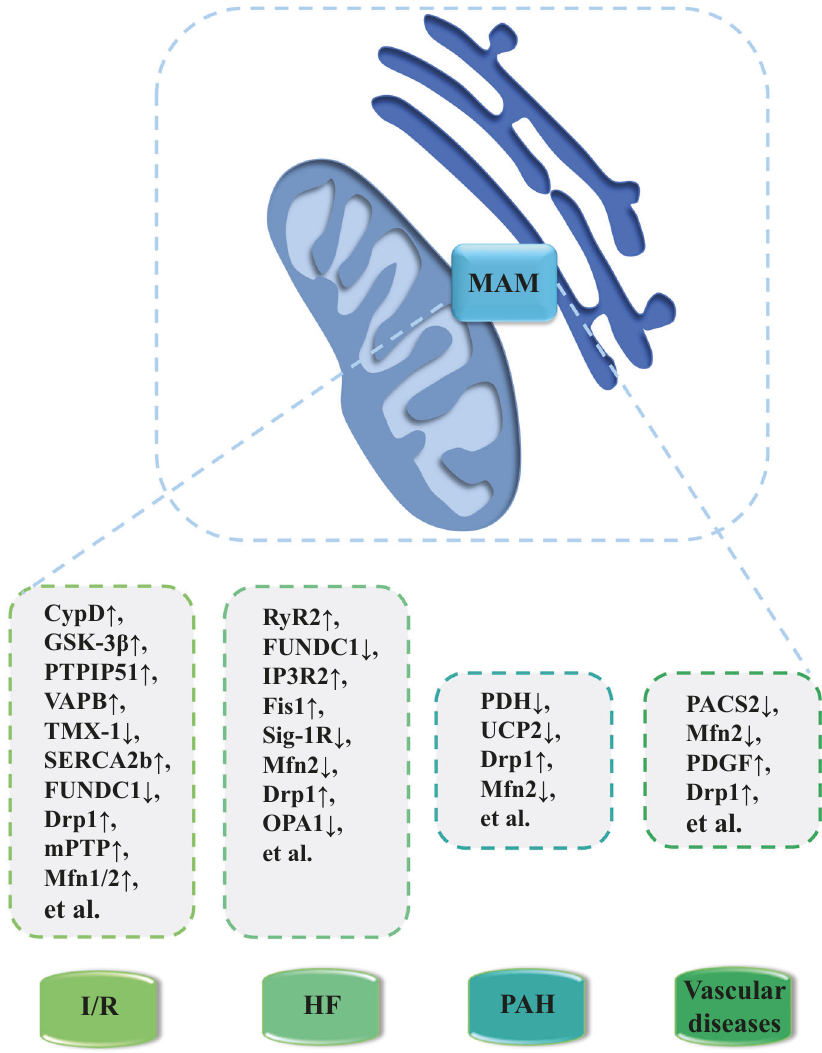
Fig. 3 MAM-enriched proteins as potential new therapeutic targets for the treatment of CVD pathologies. Disruption or de fi ciency in ER- mitochondria communication is crucial in the pathogenesis of various CVDs such as I/R, HF, PAH and vascular diseases. For example, expression level of CypD, PTPIP51 and mPTP is elevated in I/R, whereas downregulation of FUNDC1, Sig-1R and OPA1 is noted in HF. Drp1 level is increased while Mfn2 level is decreased in PAH and vascular diseases. Notably, the key regulatory proteins of these processes serve as promising therapeutic targets in the management of these pathological conditions. Abbreviations: CVD, cardiovascular diseases; CypD, Cyclophilin D; Drp1, dynamin-related protein 1; Fis1: fi ssion protein 1 homolog; FUNDC1, FUN14 domain containing 1; GSK-3 β , glycogen synthase kinase 3 beta; HF, heart failure; IP3R2, inositol 1,4,5-triphosphate receptors 2; I/R, ischemia-reperfusion; MAM, mitochondria- associated membrane; Mfn1/2, mitofusin-1 and -2; mPTP, mitochondrial permeability transition pores; OPA1, optic atrophy 1; PACS2, phosphofurin acidic cluster sorting protein 2; PAH, pulmonary arterial hypertension; PDGF, platelet-derived growth factor; PDH, pyruvate dehydrogenase; PTPIP51, protein tyrosine phosphatase interacting protein 51; RyR2, ryanodine receptor 2; SERCA2b, sarco(endo)plasmic reticulum Ca2 + -ATPases 2b; Sig-1R, sigma-1 receptor; TMX-1, thioredoxin 1; UCP2, uncoupling protein 2; VAPB, vesicle-associated membrane protein-associated mitochondrial dynamics protein of 49 and 51 kDa (MiD49 and MiD51), fostered mitotic fi ssion, impelling apoptosis resistance as well as pathological proliferation in PAH. Modulation of mitochon- drial kinetics with Drp1 inhibitor mdivi-1 or Mfn2 overexpression abrogated the phenotypic switch in PASMCs [134]. Induction of cell cycle arrest in PASMACs from PAH patients restored pulmonary artery remodeling, alleviated pulmonary vascular resistance and right ventricular hypertrophy, as well as improved cell motility in rodent models [135].